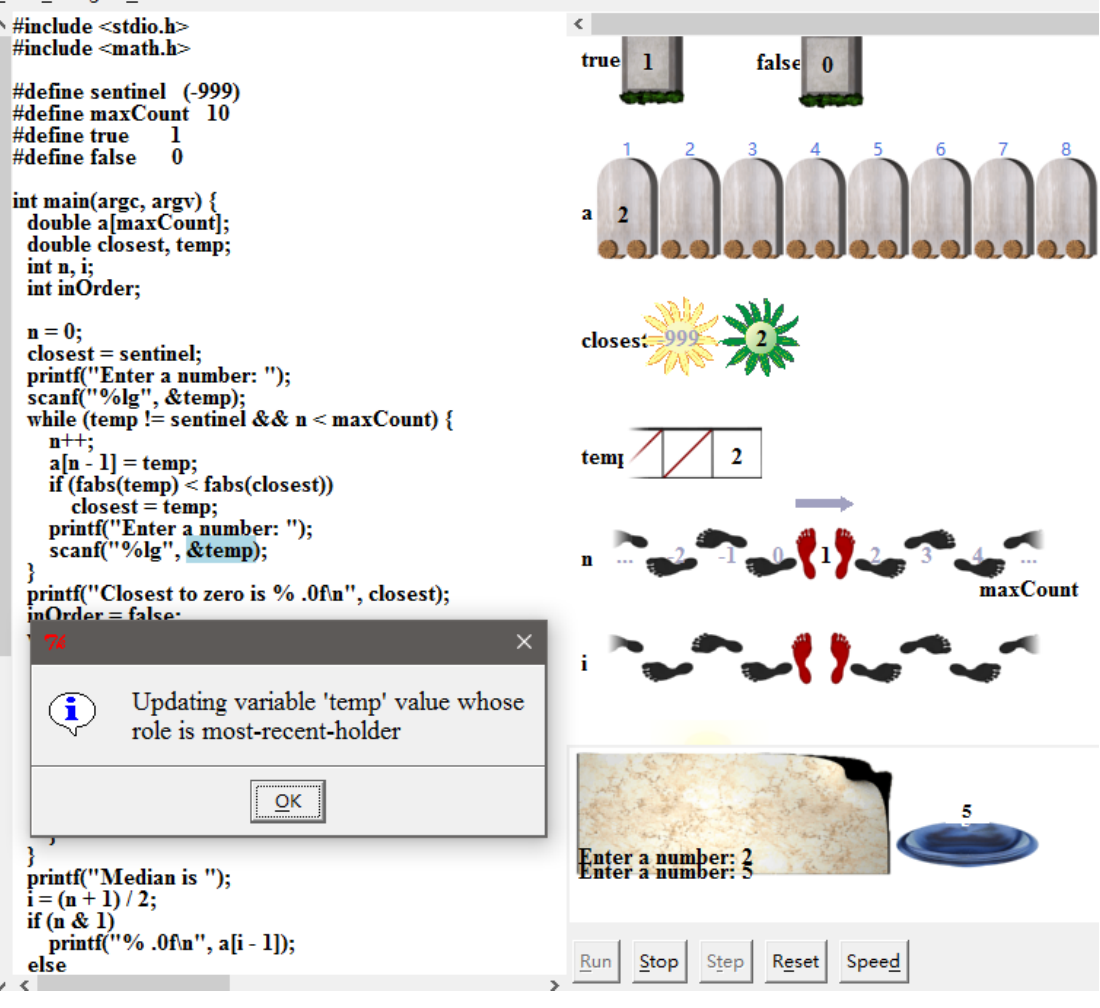
Figure 1. The interface of the PlanAni system.